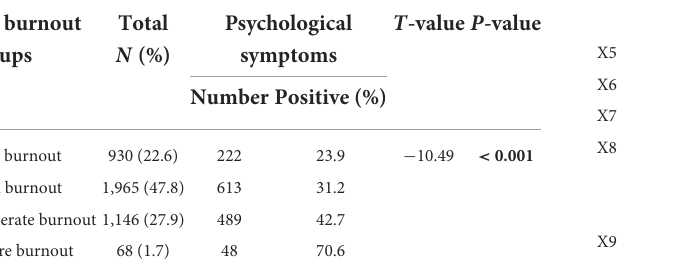
TABLE 3 Comparison of psychological symptoms among different job burnout groups.